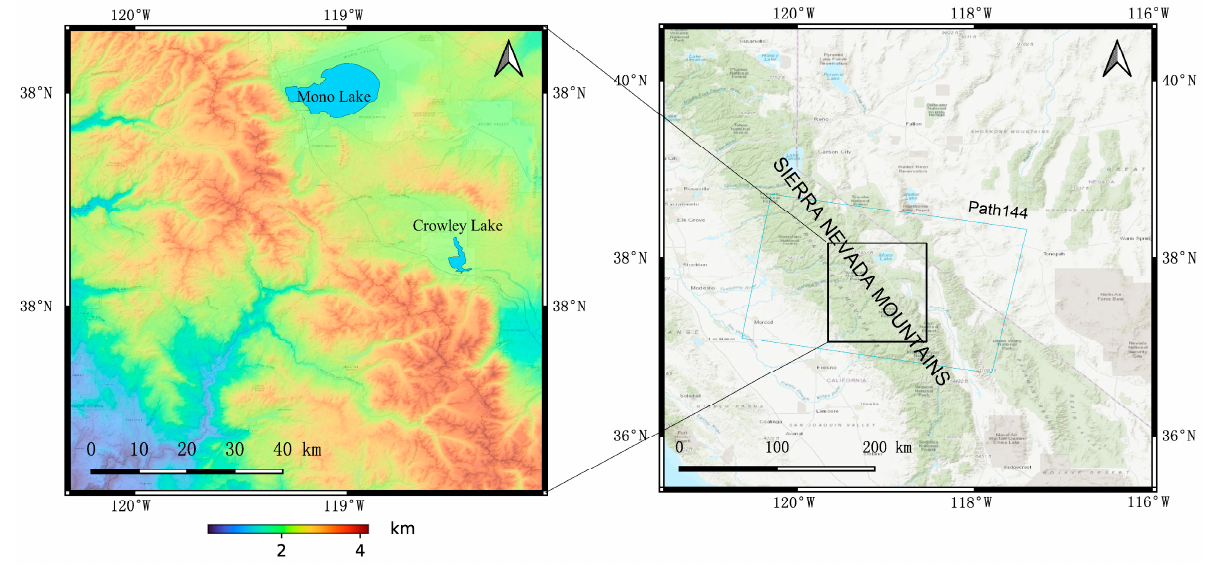
Figure 3. Reference map of the Sierra Nevada Mountains with maximum elevation up to 4.13 km. The blue frames are the coverage of the Sentinel-1A data.